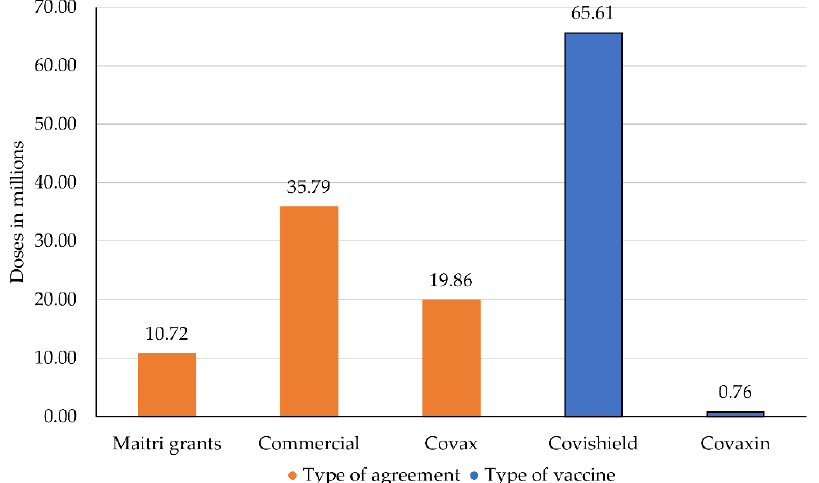
Figure 3. Exported COVID-19 vaccines by type of agreement and type of vaccine. Own illustration, data compiled from Ministry of Science & Technology, and Press Trust of India [42,43].